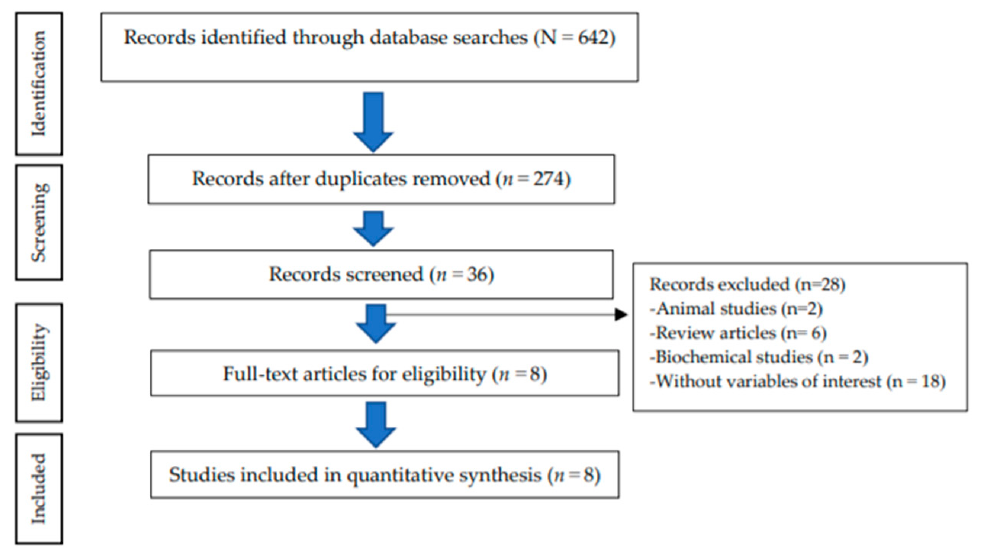
Figure 1. Flow chart of the study selection process (PRISMA).